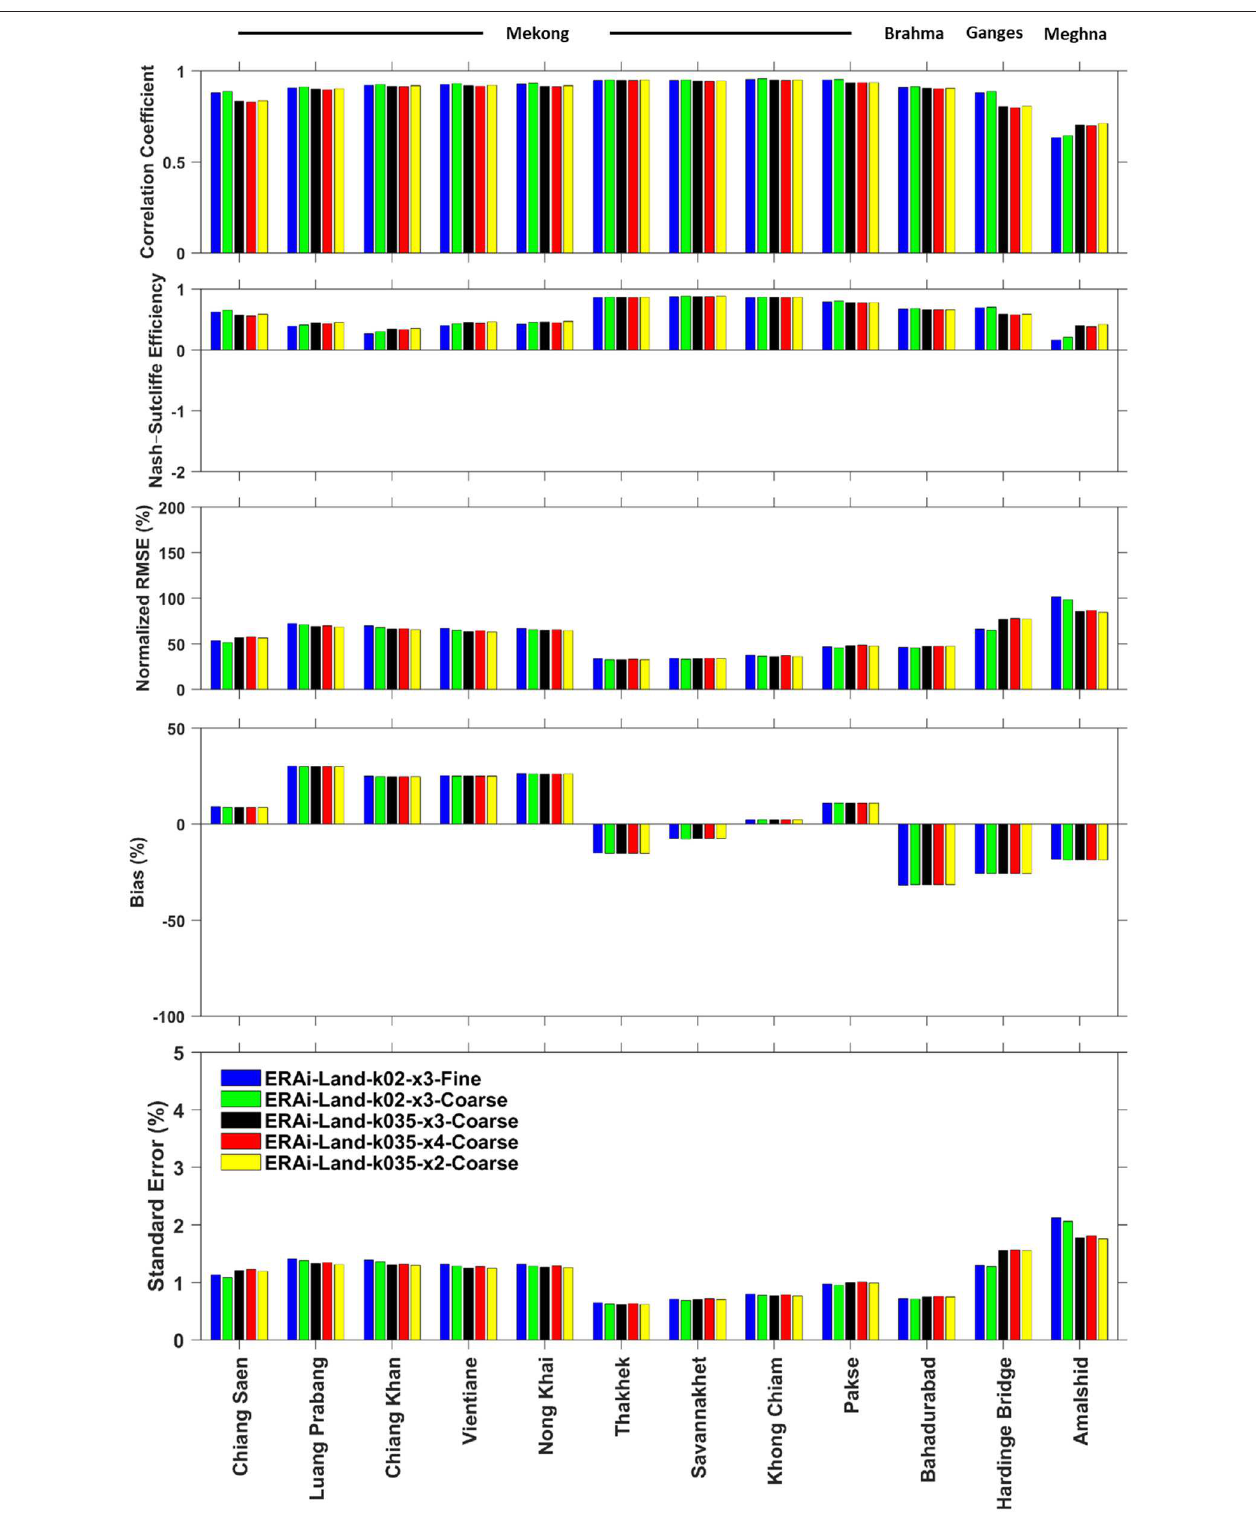
FIGURE 8 | Sensitivity of using different flow routing parameters at different locations of the Mekong and GBM basins. All the routing simulations were conducted with the same LSM outputs (i.e., ECMWF-ERA-interim/Land).